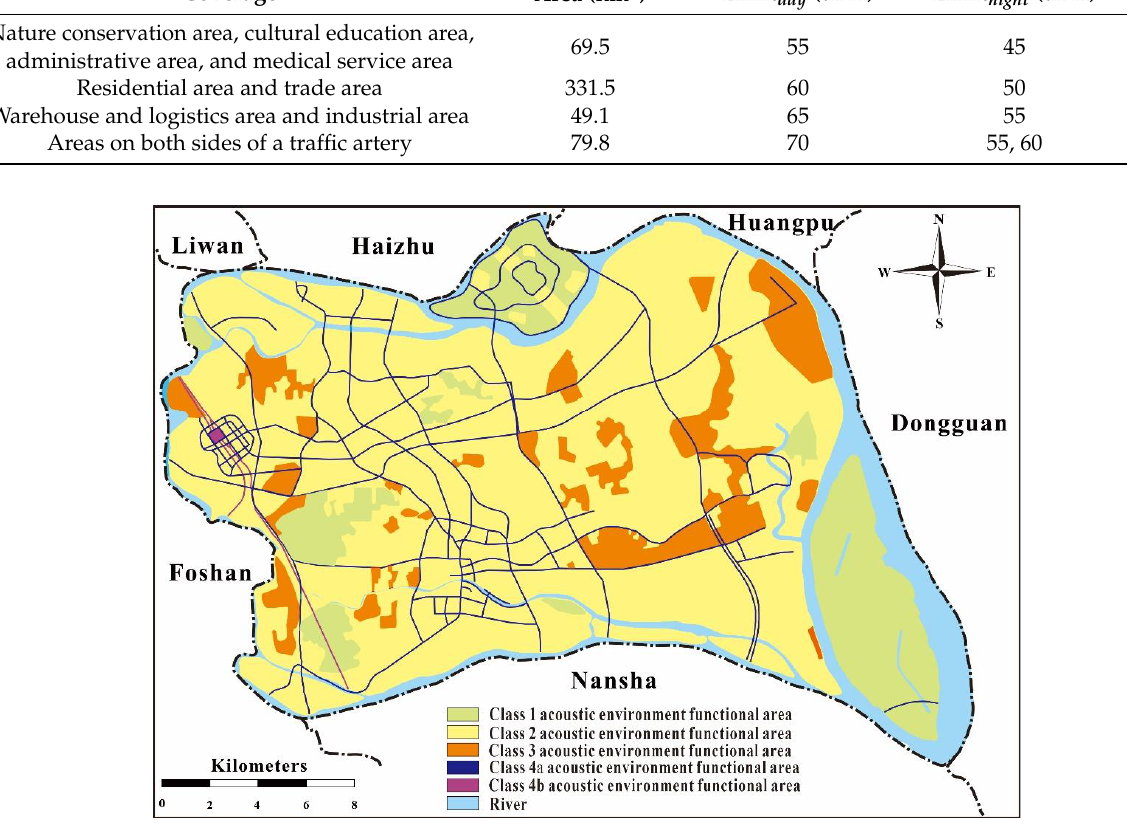
Figure A4. Acoustic environment functional areas in Panyu District of Guangzhou City [56]. Table A2. Classification of environmental noise quality levels in urban areas [47].